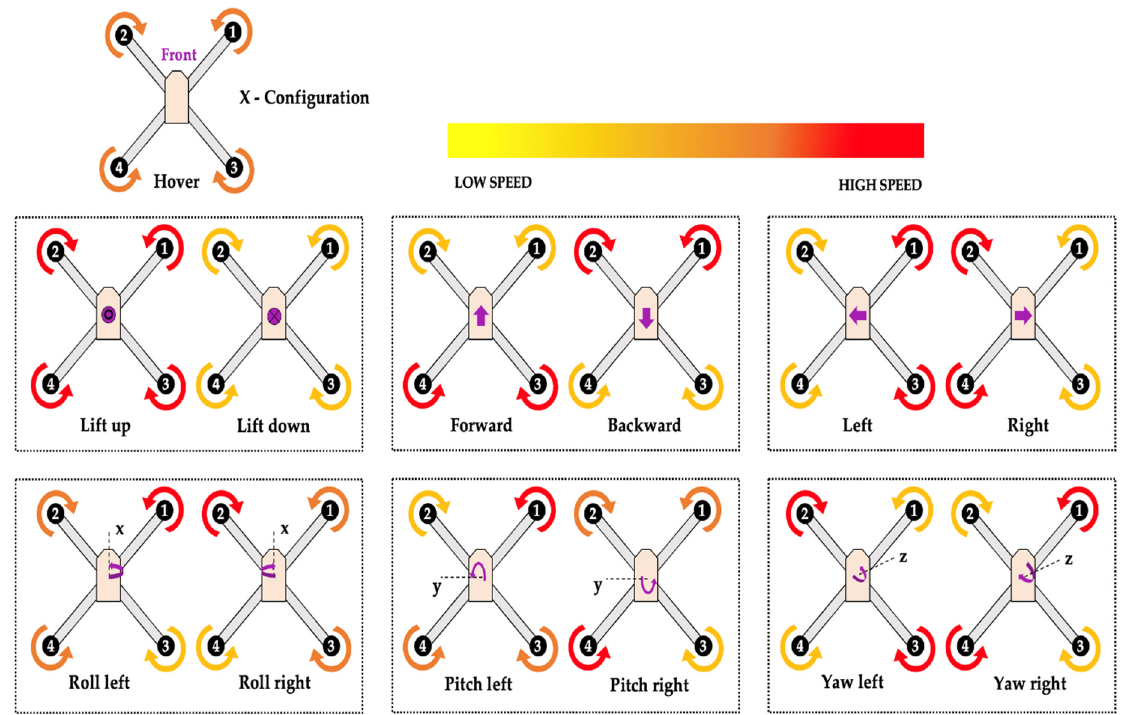
Figure 1. The possible motions of quad-rotor with cross configuration.